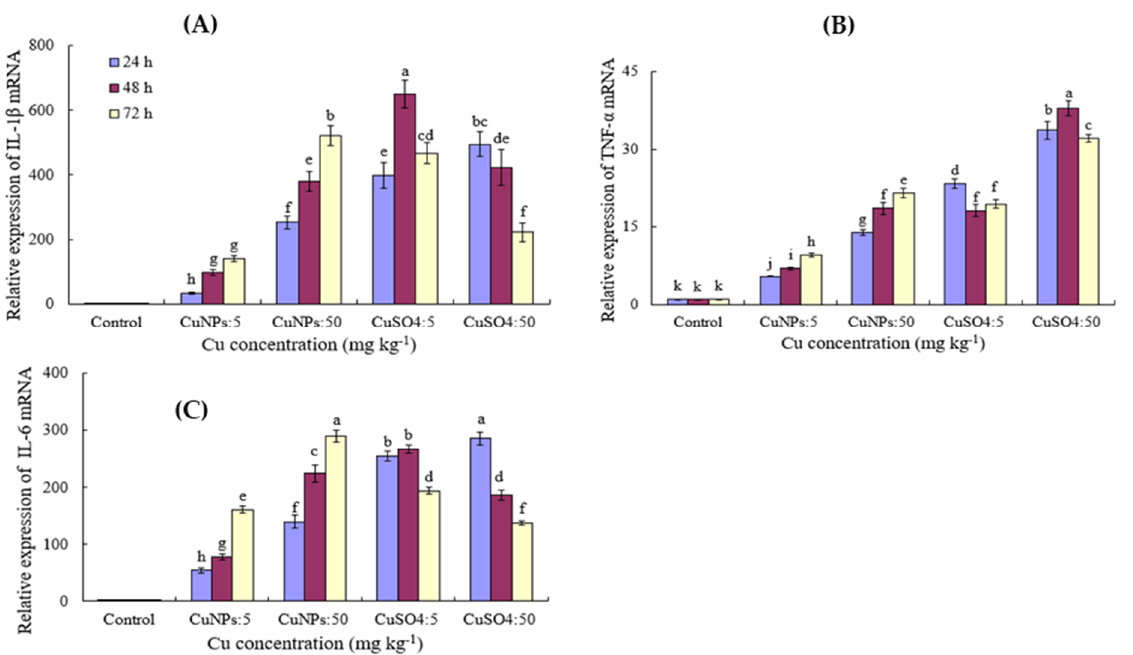
Figure 4. The relative inflammatory factors mRNA expression with the treatment of CuNPs and CuSO 4 . ( A – C ) represent the relative expression levels of IL-1β, TNFα, and IL-6 mRNA, respectively. Different letters at the top of the histogram indicate significant differences between groups ( p < 0.05).